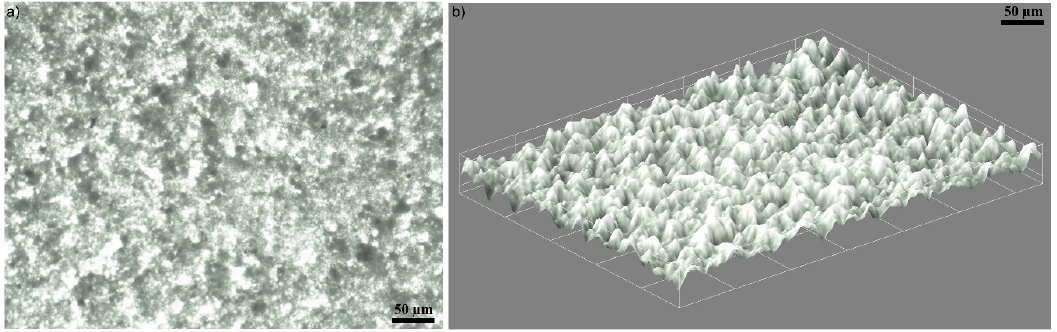
Figure 5. Representation of the atomic force microscopy (AFM) topography image of the AgZnHApCs coating’s surface ( a ) and 3D representation of the surface topography of AgZnHApCs coatings ( b ).